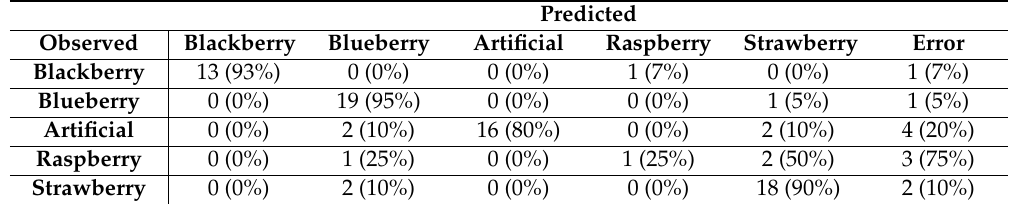
Table 2. Random forest model (number of trees: 200; no. variables tried at each split: 2; OOB error rate: 7.33%) performance classifying Drosophila suzukii adults according to larval diet in the test data set, indicating the number classified and the percentage correct or incorrect classification in parentheses.